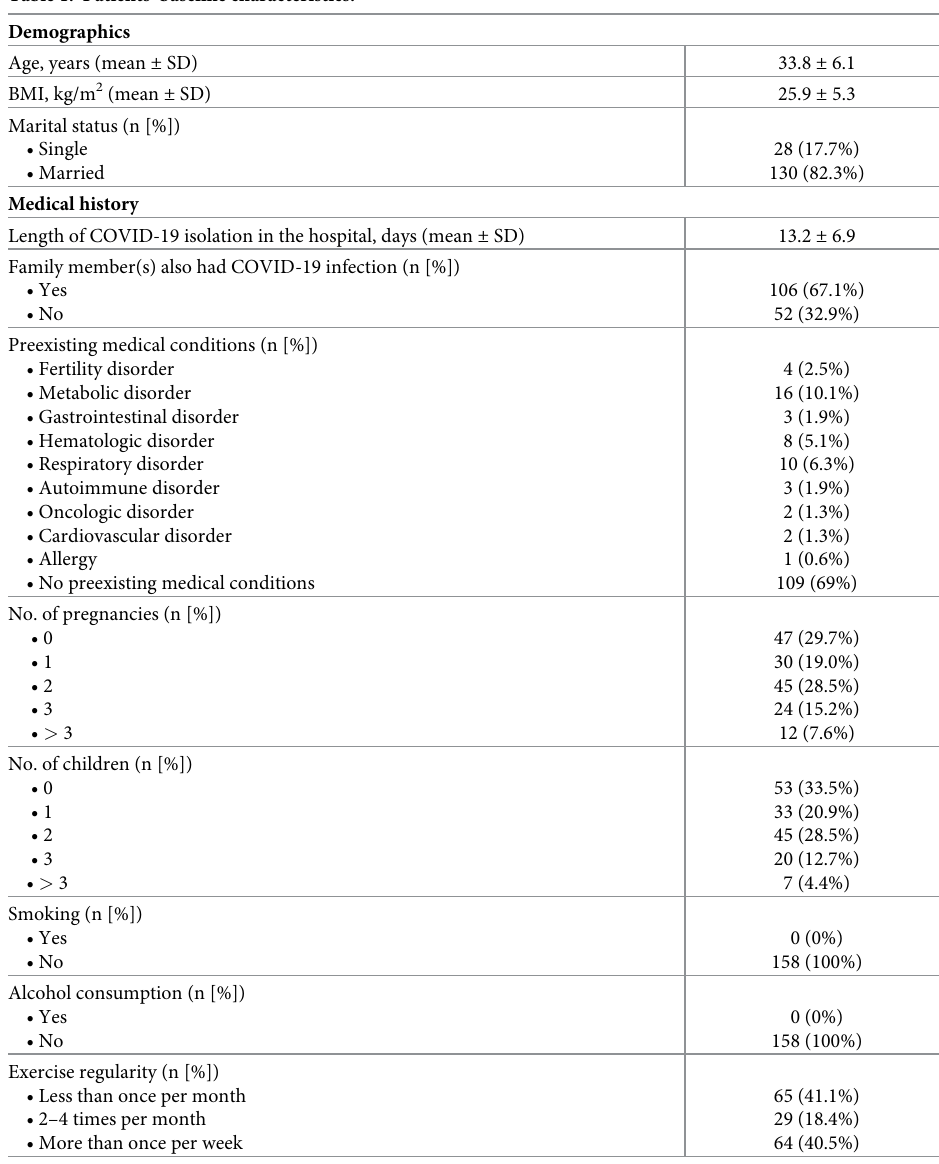
Table 1. Patients’ baseline